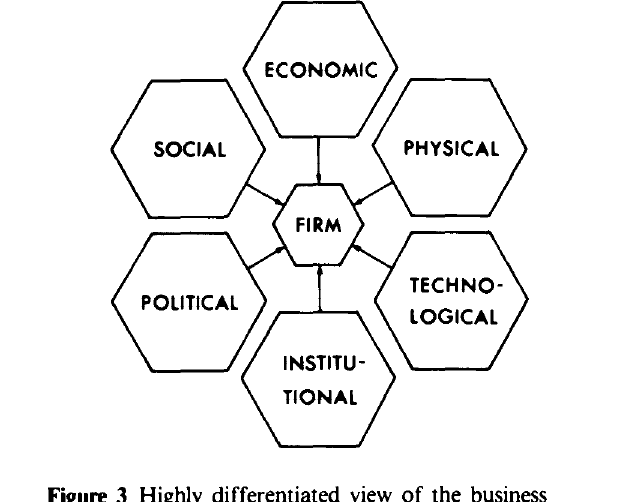
Figure 3 Highly differentiated view of the business environment - Environmental